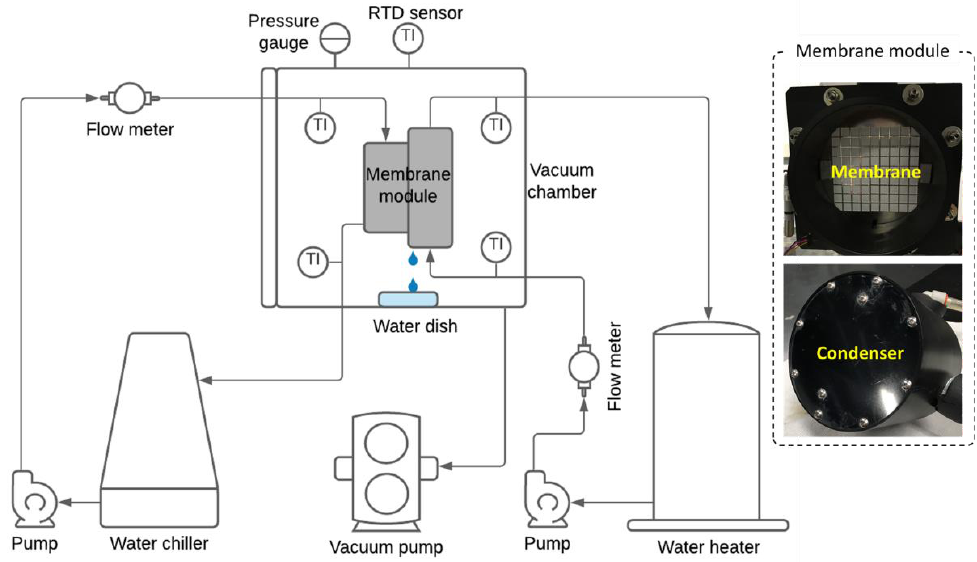
Figure 9. Schematic diagram of the bench-scale test facility for vacuum-applied AGMD.